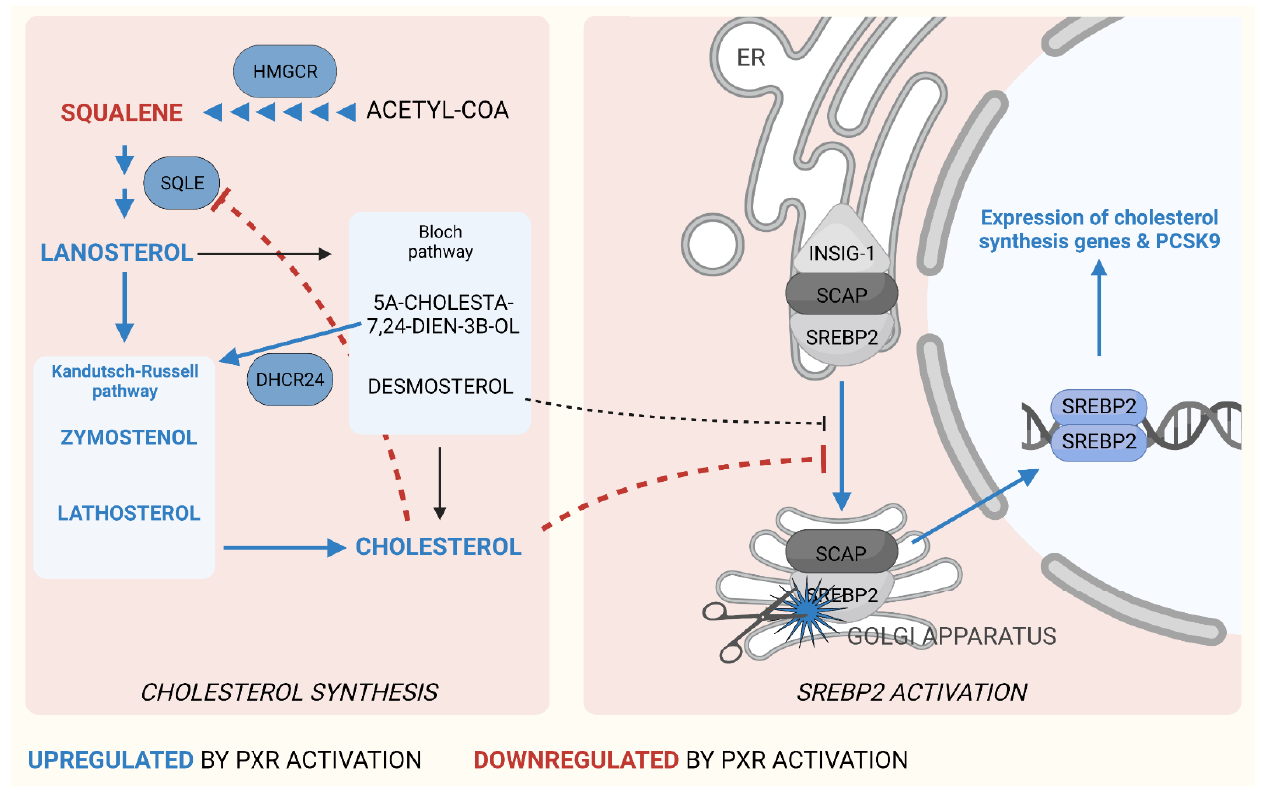
Figure 1. Activation of PXR stimulates cholesterol synthesis and induces Pcsk9 in the liver. The processes and molecules upregulated and downregulated by PXR activation have been indicated with blue and red coloring in the figure, respectively. PXR activation leads to nuclear accumula- tion of SREBP2, which consequently induces cholesterogenic genes, including the rate-limiting enzyme HMGCR, and thus induces cholesterol synthesis. Furthermore, PXR activation directly induces Sqle to increase the rate of squalene epoxidation. Induction of DHCR24 enzyme targets cholesterol synthesis flux to the Kandutsch – Russell pathway instead of the Bloch pathway. PXR activation appears to bypass the usual negative feedback mechanism controlling cholesterol syn- thesis, including inhibition of SREBP2 – SCAP complex translocation from the ER to the Golgi ap- paratus by high cellular cholesterol levels and desmosterol, as well as the inhibitory effect of cho- lesterol on SQLE activity. Accumulation of plasma LDL-C level is potentiated by induction of the hepatic Pcsk9 gene and a consequent increase in circulating PCSK9 levels.